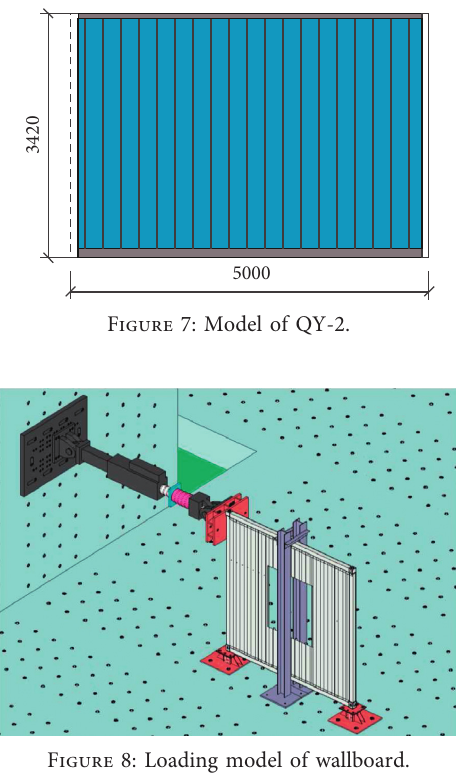
Figure 8: Loading model of